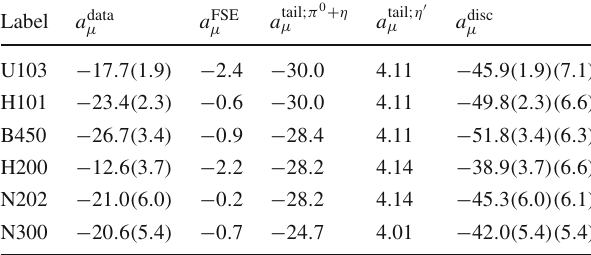
Table 9 Finite-volume corrected disconnected contributions to a hlbl μ at the SU ( 3 ) f -symmetric point. A breakdown of the FSE contributions to thetotalresultsareshown,againa25%systematictothetotalfinite-size correction is used. The value of | y | cut was 1 . 2 fm for each